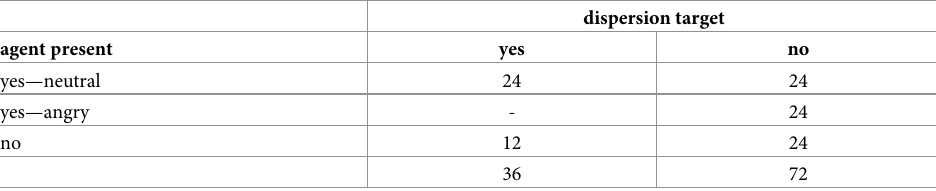
Table 3. Trial distribution.